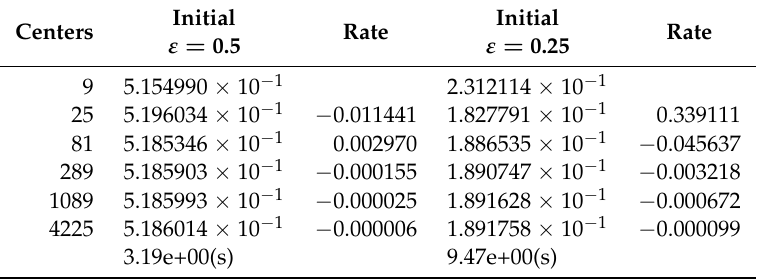
Table 7. Multilevel collocation: with initial 0.5 and 0.25.